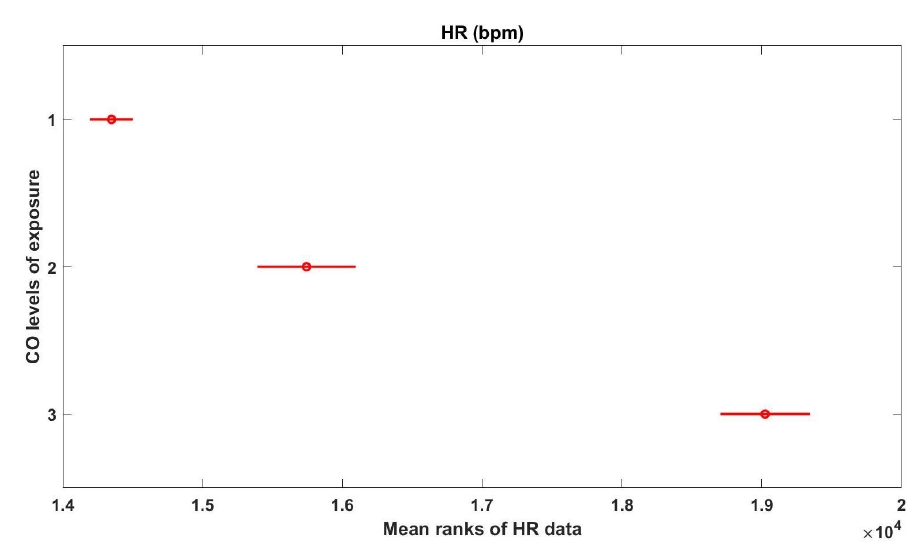
Figure 7. Multicomparison graphics for the mean ranks of HR, for each level of CO exposure.